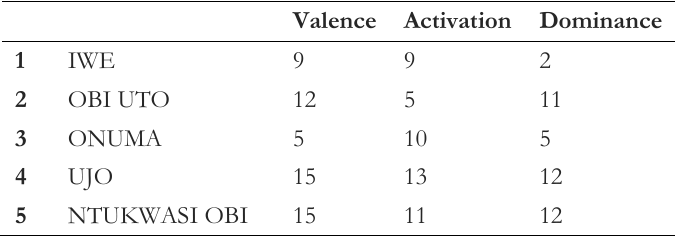
Table 8. Sample result of reasonable interval